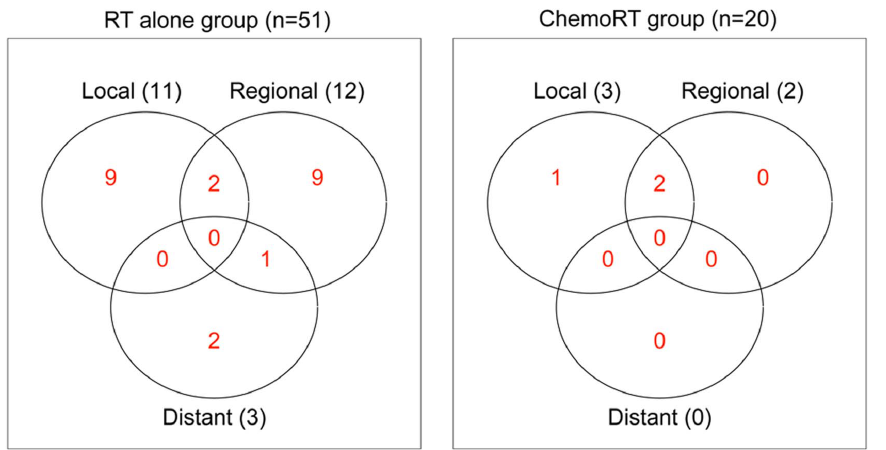
Figure 3. Cox Proportional Hazards Analyses Results from univariate Cox proportional hazards analyses for DFS and OS are presented in Table 3. On univariate analysis for predictors of DFS, year of diagnosis, use of concurrent chemo- therapy, FIGO stage, and tumor size . 4 cm were significant variables. Variables that were not significant included lymph node involvement, tumor differentiation, age at diagnosis, use of surgery, prior hysterectomy, treatment duration, and use of 3D diagnostic imaging. Significant univariate predictors of OS included year of diagnosis, use of concurrent chemotherapy, radiation dose (EQD2), use of both EBRT and brachytherapy,